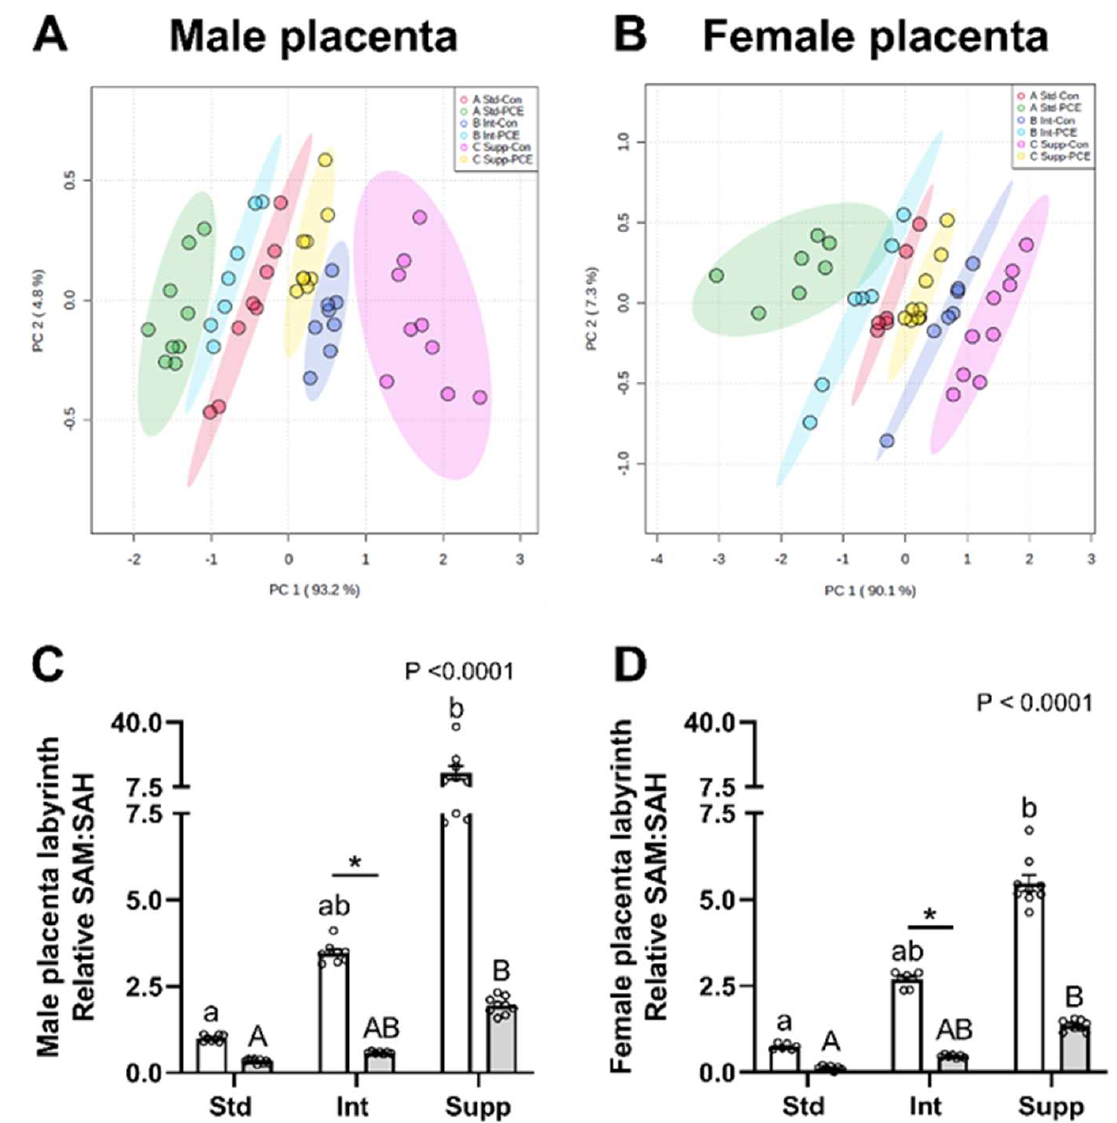
Figure 3. The effects of periconceptional ethanol and choline supplementation on the one-carbon metabolism (1CM) pathway in the placenta. Principal components analysis (PCA) of 12 molecules from the 1CM pathway across the 6 experimental groups in placentas of ( A ) male and ( B ) female fetuses. Molecules were measured using mass spectrometry. Standard chow (1.6 g choline/kg chow, Std) with control (0% EtOH, Con) liquid diet (Std-Con, red); Std with periconceptional ethanol (12.5% v / v EtOH, PCE) liquid diet (Std-PCE, green); intermediate chow (2.6 g choline/kg chow, Int) with Con (Int-Con, dark blue); Int with PCE (Int-PCE, light blue); supplemented chow (7.2 g choline/kg chow, Supp) with Con (Supp-Con, pink); Supp with PCE (Supp-PCE, yellow). Individual analysis of the s-adenosylmethionine:s-adenosylhomocysteine ratio (SAM:SAH) in placentas of ( C ) male and ( D ) female fetuses. Open bars are Con and grey bars are PCE ( n = 6–9 per group). Data expressed as fold-change relative to the male Std-Con group (mean ± SEM). Kruskal–Wallis test for non-parametric data was used to identify significant differences across all 6 groups, and Dunn’s post hoc analysis for differences between Con and PCE within each chow group; * p < 0.05; differences between Con groups are shown by lower-case letters, and between PCE groups by upper-case